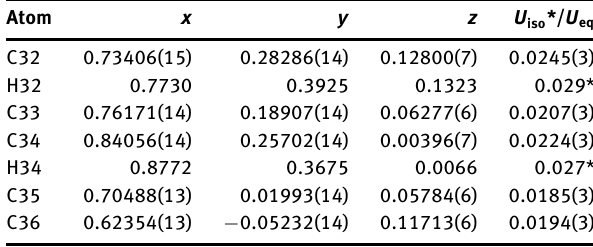
Table 2: Fractional atomic coordinates and isotropic or equivalent isotropic displacement parameters (Å 2